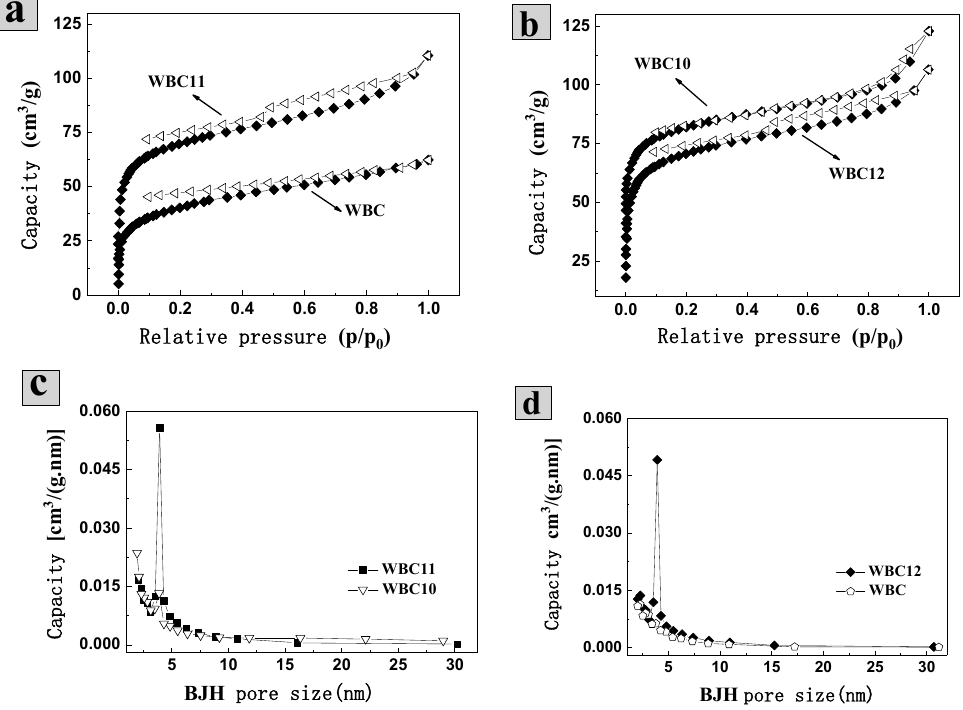
Figure 2. N 2 -adsorption/desorption isotherms and aperture profile of WBC and WBC1x. ( a ) N 2 - adsorption/desorption isotherms of WBC ( ♦ ) and WBC 11(Δ); ( b ) N 2 -adsorption/desorption isotherms of WBC10(Δ) and WBC 12 ( ♦ ); ( c ) BHJ aperture distribution of WBC1 0( ∎ ) and WBC 11( ▽ ); ( d ) BHJ aperture distribution of WBC ( ○ ) and WBC 12 ( ♦).